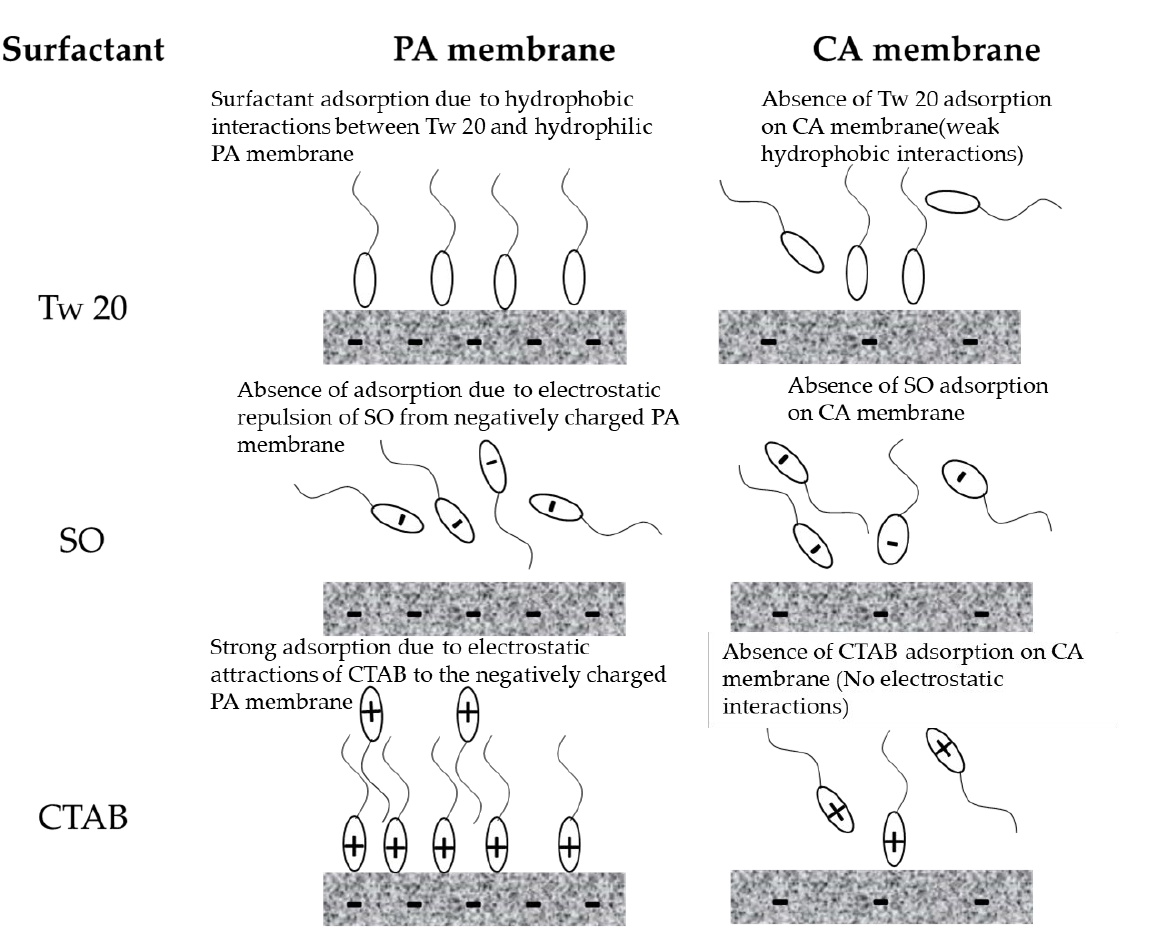
Figure 7. Schematic representation of interaction between RO membranes and surfactants.